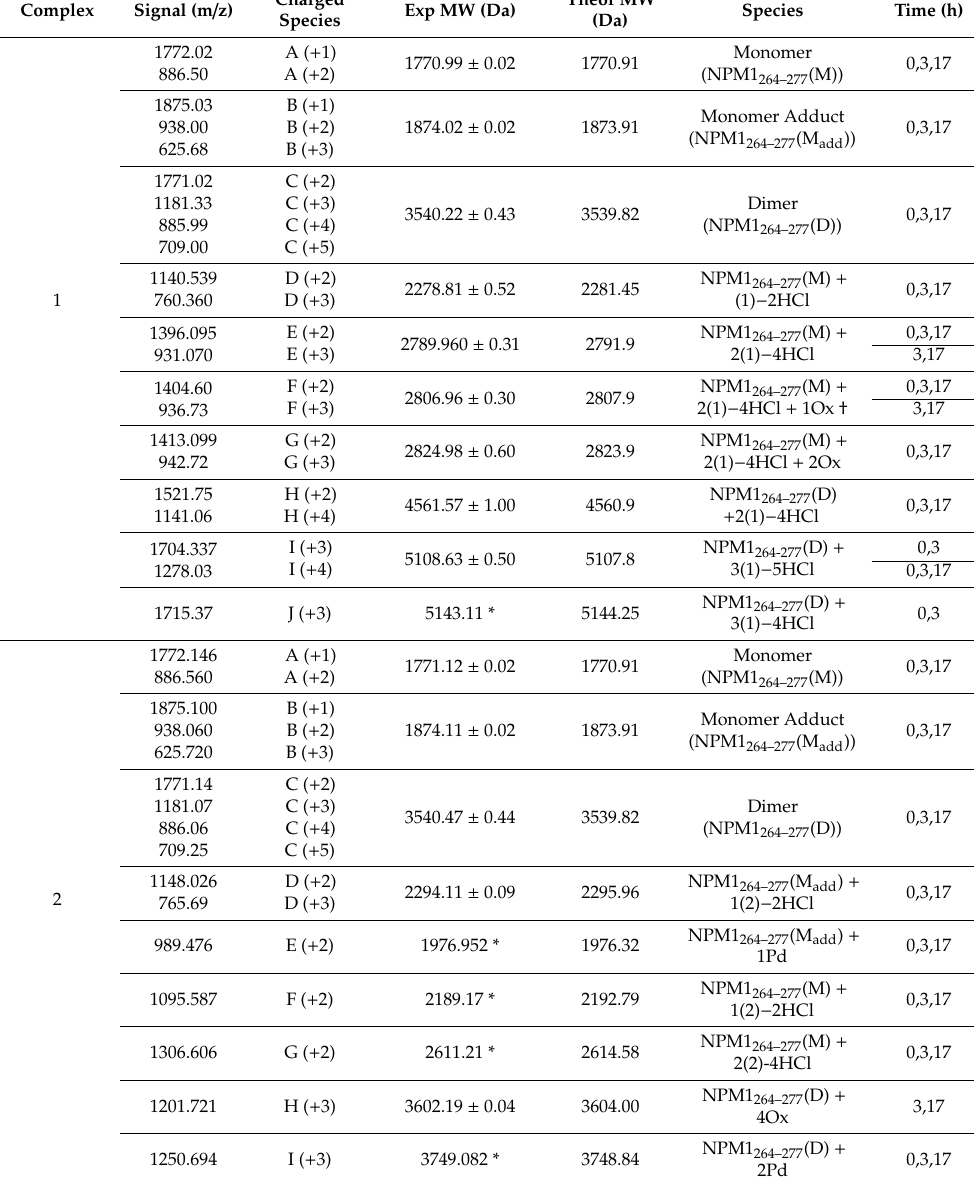
Table 2. Results of the ESI-MS analysis of the adducts formed upon reaction of NPM1 264–277 with 1 – 3 . The experimental m / z values, the ion charge status, the experimental (Exp) and theoretical (Theor) monoisotopic mass values, the corresponding ion species and times of incubation are